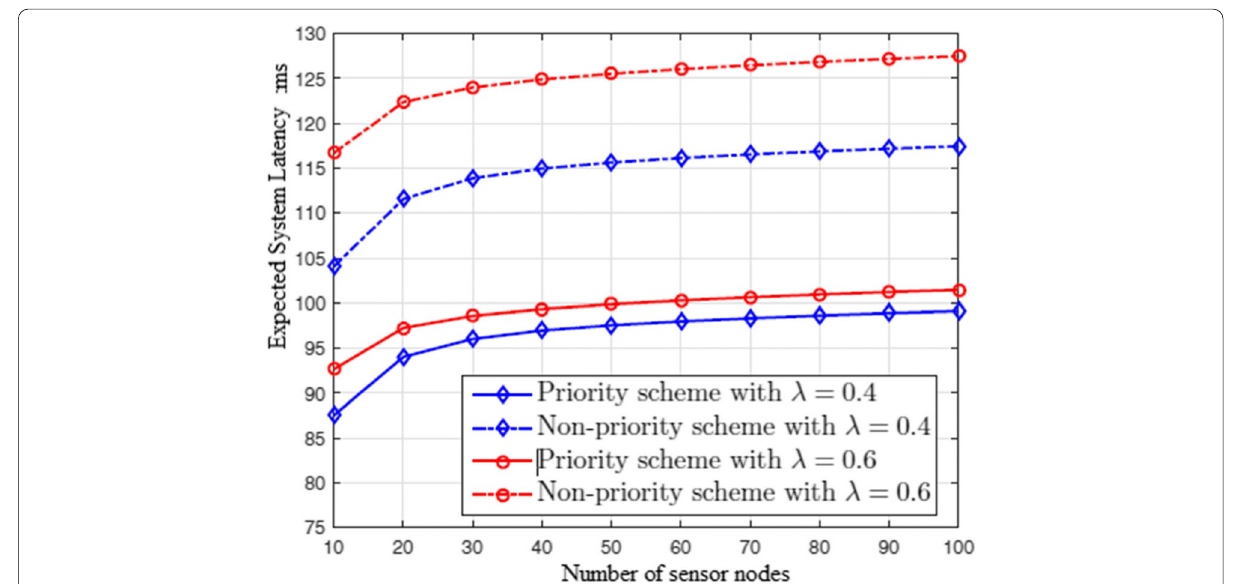
Fig. 6 Performance comparison of the proposed priority scheduling to nonpriority scheduling